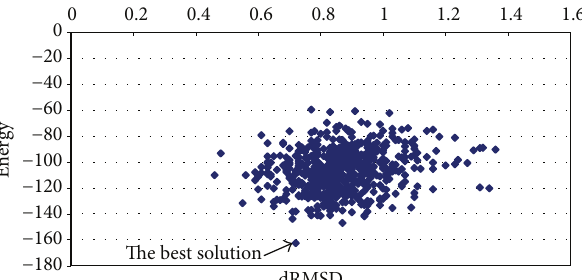
Figure 7: Graphic of average energy and dRMSD (Met 5 -enkaphalin instance).